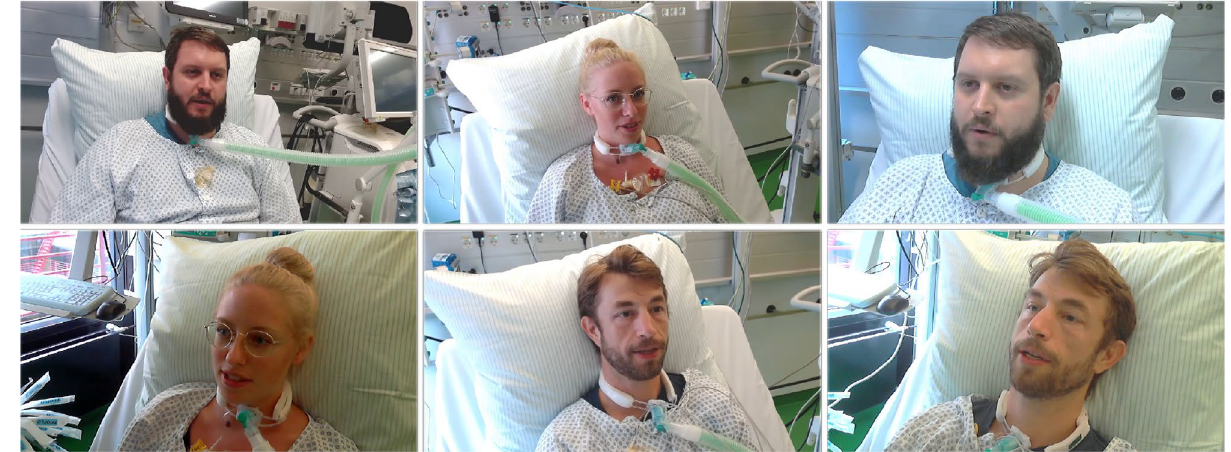
Figure 2. Sample frames from our VSRICU dataset, recorded at the University Hospital of